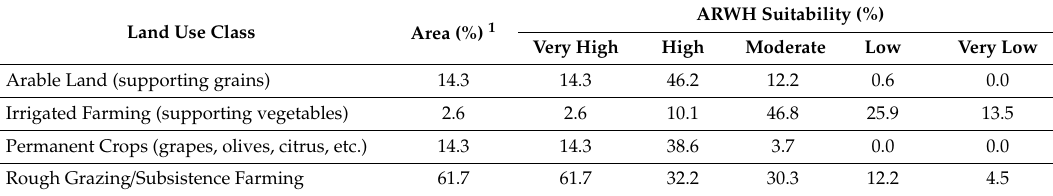
Table 8. Percentage of the ARWH suitability classes for the di ff erent types of land use in the West Bank. Land Use Class Area (%) 1